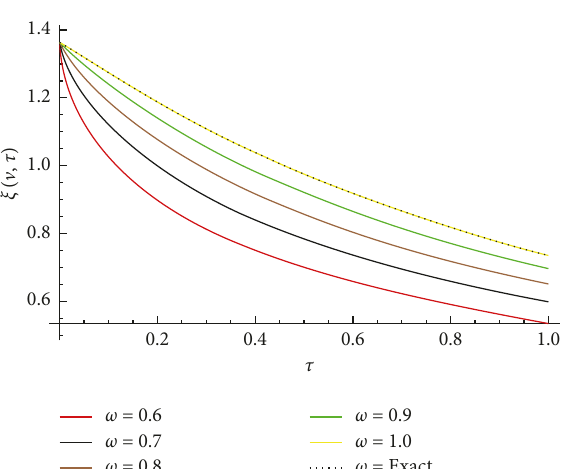
Figure 1: Approximate solutions for different values.